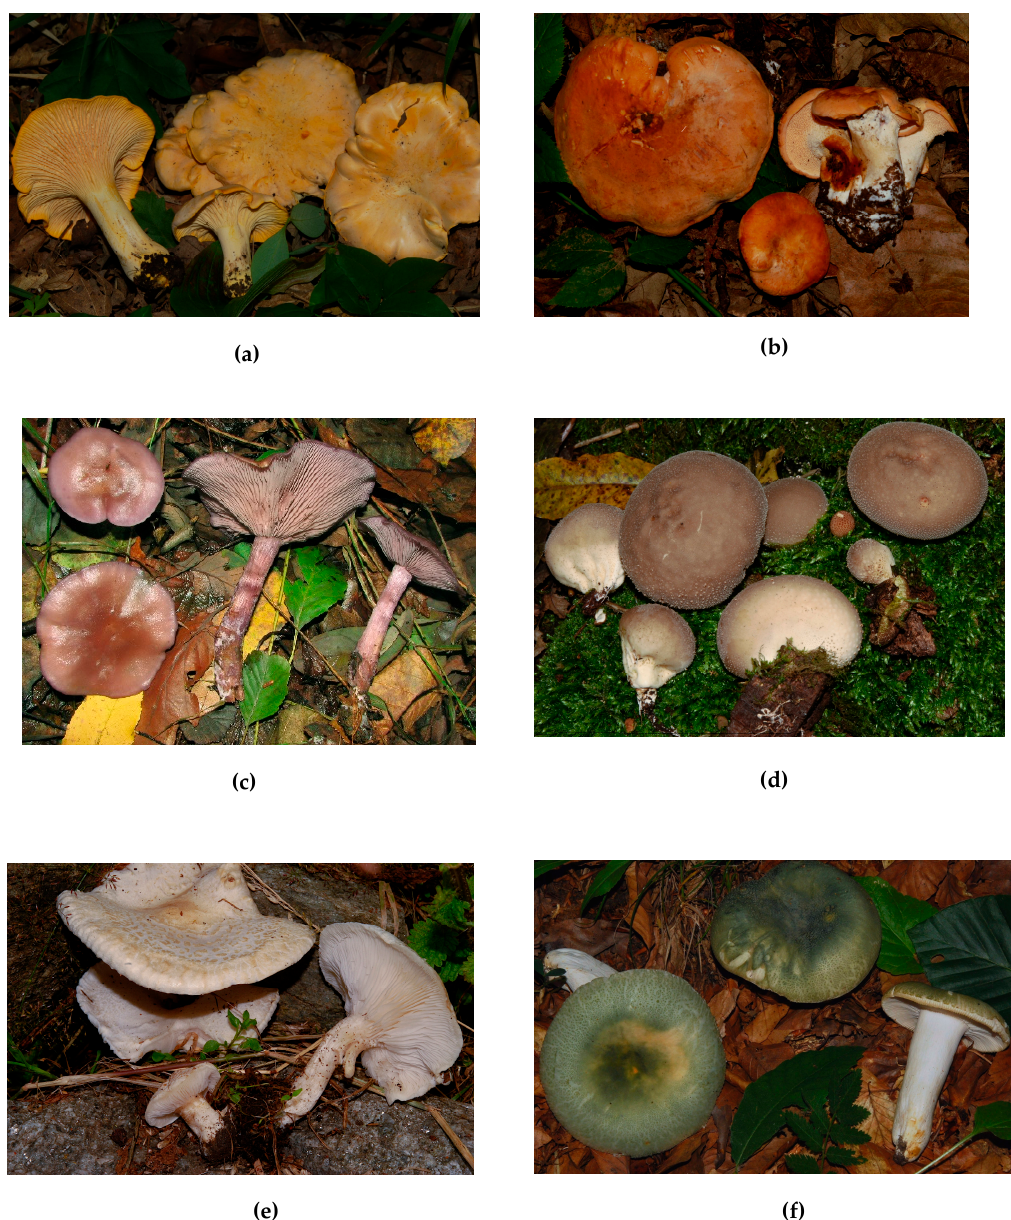
Figure 2. ( a ) Cantharellus cibarius ; ( b ) Hydnum repandum ; ( c ) Lepista sordida ; ( d ) Lycoperdon pyriforme ; ( e ) Neolentinus lepideus ; ( f ) Russula virescens .